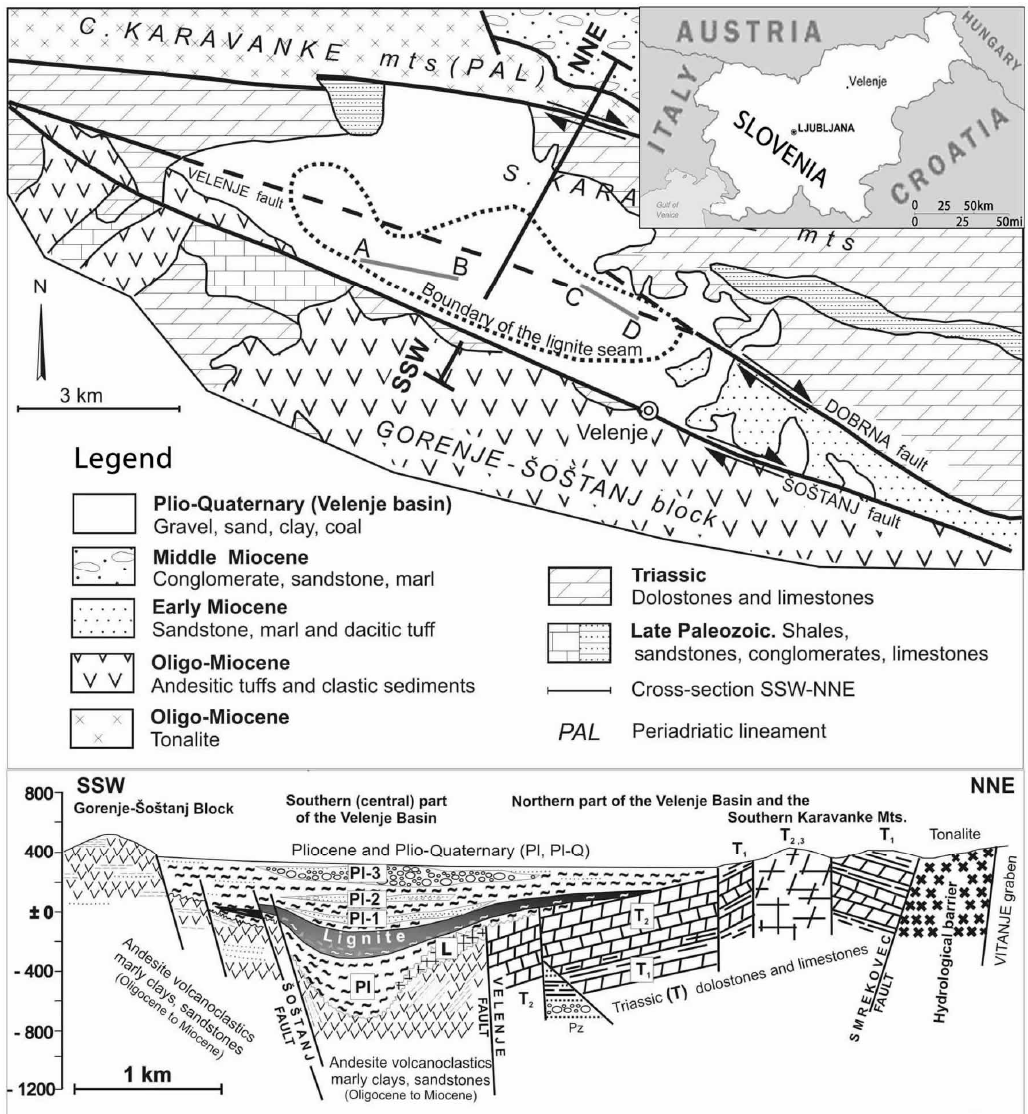
Figure 1. A geological, SSW-NNE cross-section of the lignite mine in Velenje. The multi-layered aquifer system (Pl-1, Pl-2 and Pl-3) depicted is made up of sand strata atop a lignite stratum [4,5].